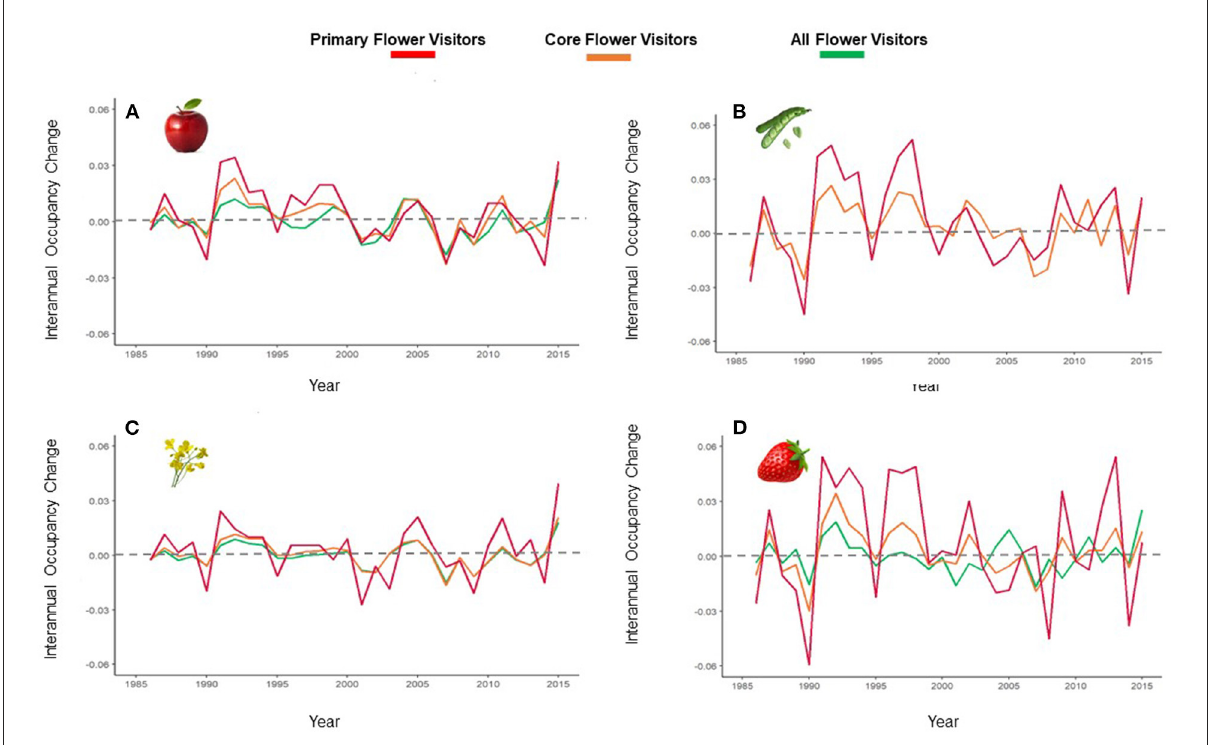
FIGURE3 Mean inter-annual occupancy change of primary, core and all visitors for (A) apple, (B) bean (primary and core only), (C) oilseed and (D) strawberry crops. Dashed gray line denotes a mean inter-annual occupancy change of zero.